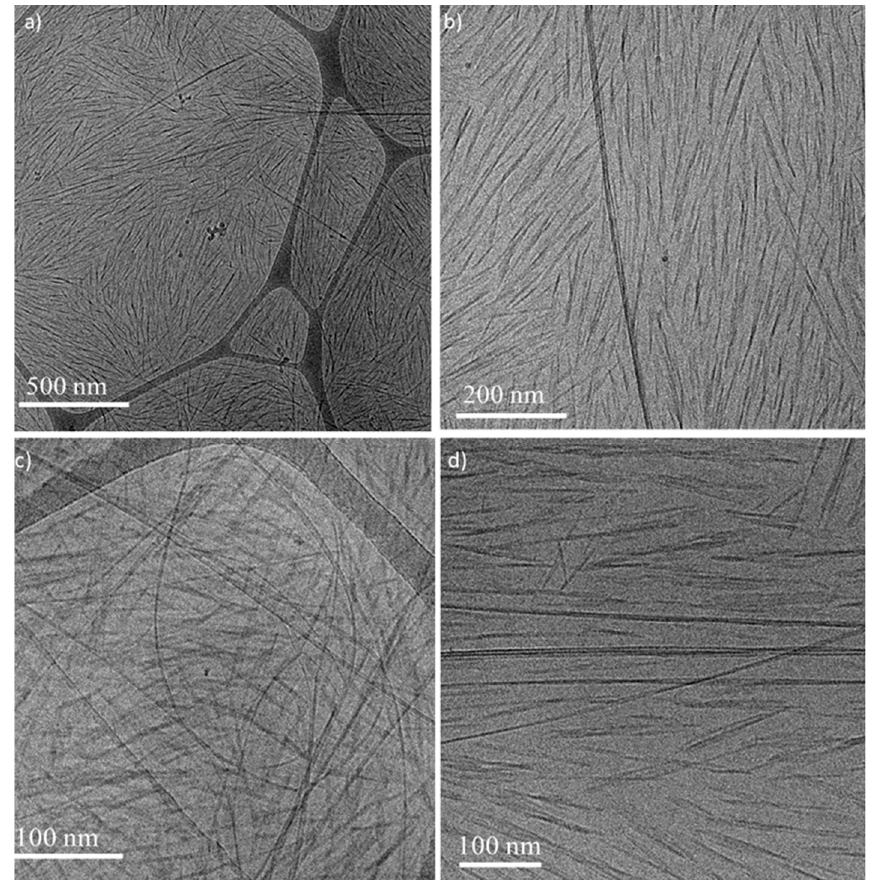
Figure 5. Cryo-TEM images of ( a , b ) the N* phase of CNC–F108–SWNTCH suspensions. ( c ) The upper (isotropic) and ( d ) lower ( N* ) phase of CNC–F127–SWNTCH.